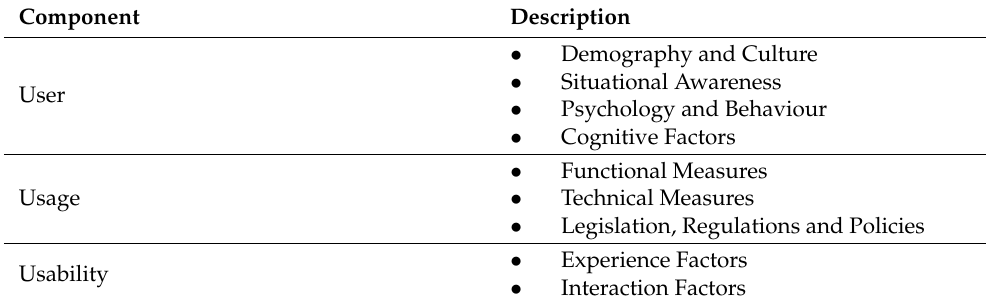
Table 2. Design, implementation and assessment of holistic human-centric cyber security systems.